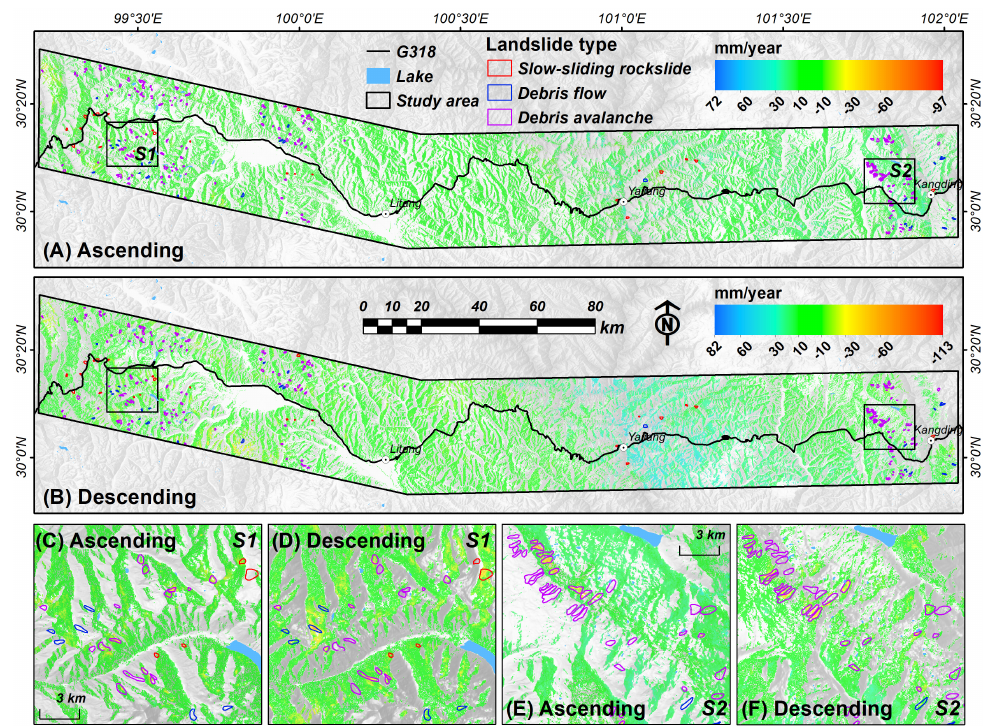
Figure 4. Results of deformation and landslide identification in the study area: ( A ) ascending, ( B ) ( B ) descending, ( C – F ) enlarged maps of subregions. The base map is the hillshade data calculated descending, ( C-F ) enlarged maps of subregions. The base map is the hillshade data calculated from from the the DEM.